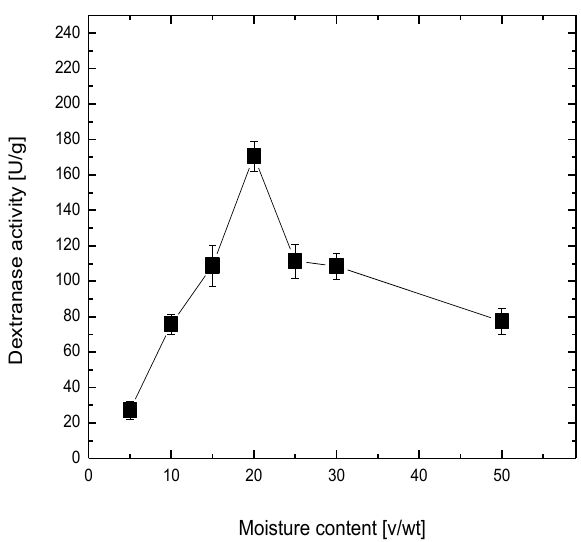
Figure 3. Effect of different moisture content on dextranse production from Bacillus subtilis NRC-B233b .